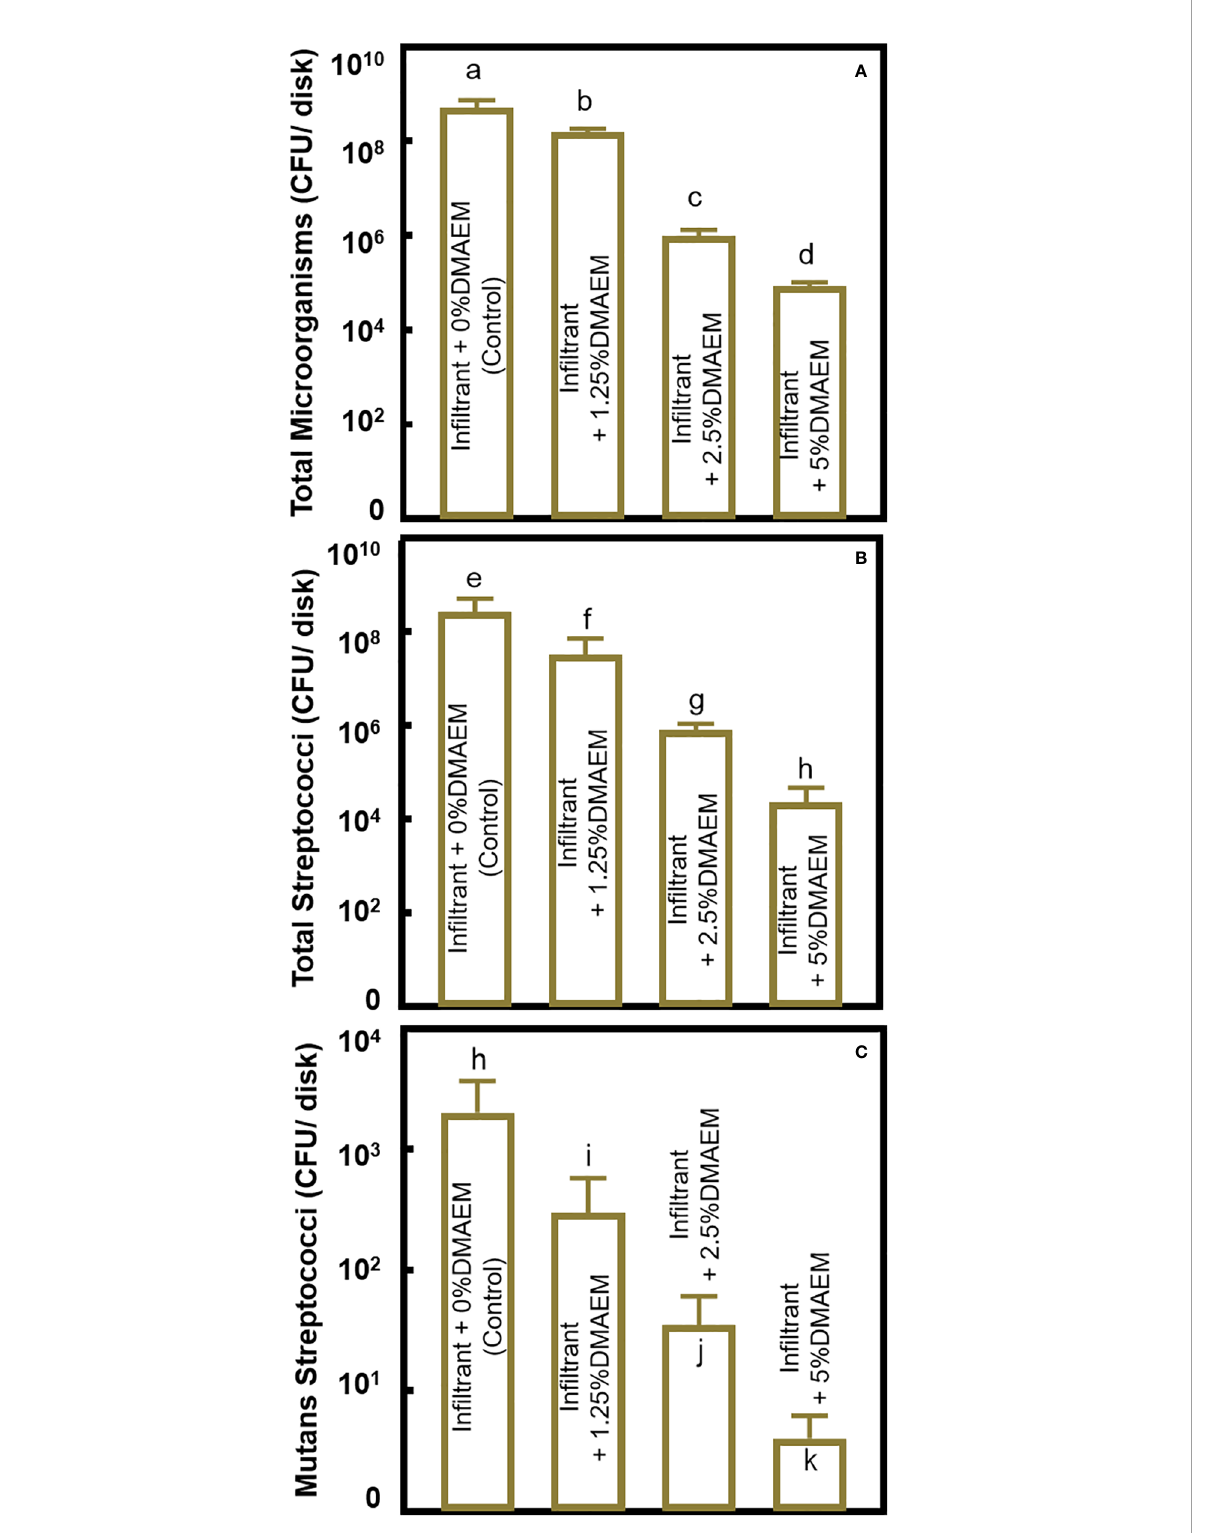
FIGURE 5 CFUs of the bio fi lm. (A) CFU of total microorganisms, (B) CFU of total streptococci , (C) CFU of mutans streptococci (mean ± SD; n = 6). The different letters indicate the signi fi cant difference between the bars (a, b,